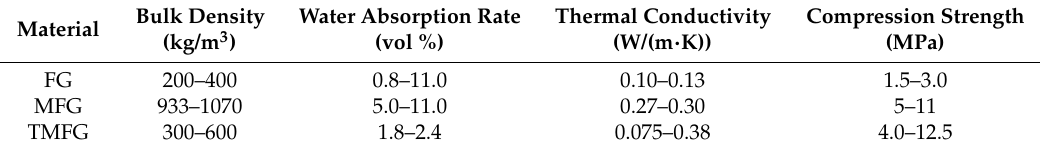
Figure 1. Tailing microcrystalline foam glass (TMFG). ( a ) TMFG with a microcrystalline decoration surface; ( b ) TMFG slab. Table 1. Flexural strength (MPa). FG: foam glass; MFG: microcrystalline foam glass; TMFG: Tailing microcrystalline foam glass.